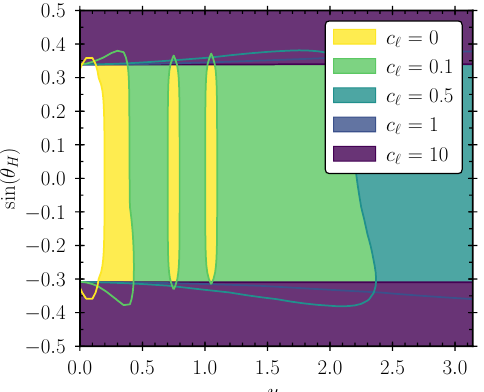
Figure 10 . 95 % exclusion limits from signal strength measurements by ATLAS and CMS on the Higgs mixing angle and the heavy electron Yukawa